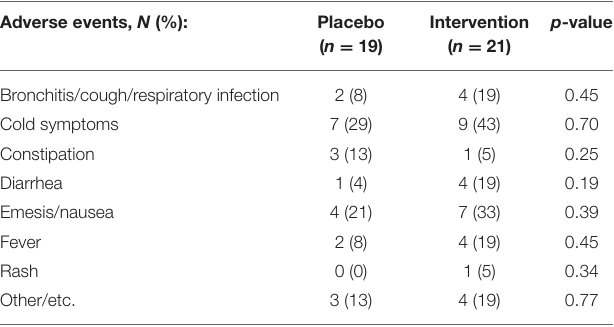
TABLE 6 | Adverse events or acute health complications reported throughout the